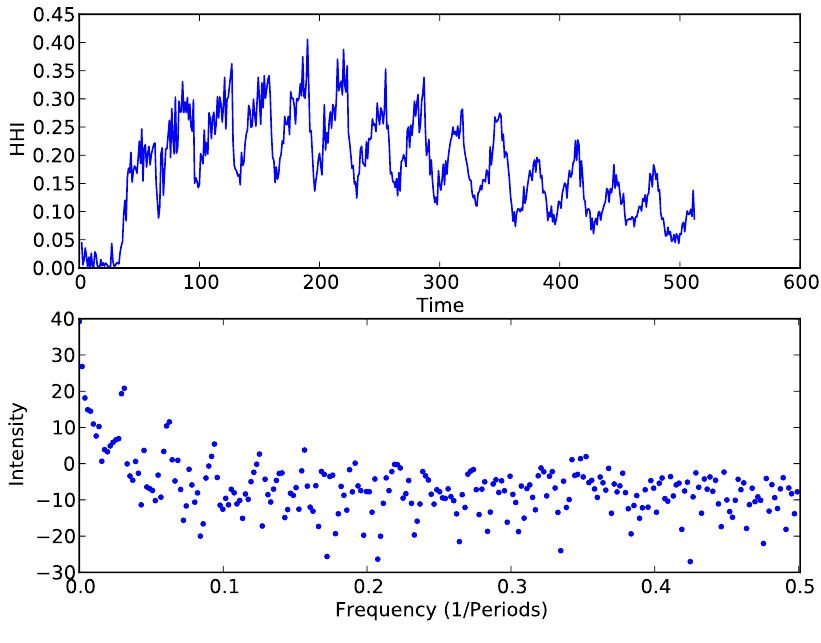
Figure 14. Development of the heterogeneity of the population (with respect to adherence to institutions) measured by the Herfindahl-Hirschman Index and the frequency spectrum of the Herfindahl index time series for ↵ = 3 . 0 (see, also, figure